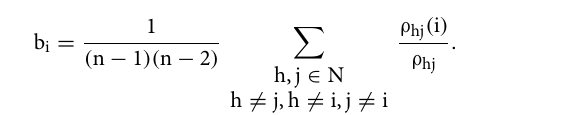
Clustering coefficient. Clustering coefficient assesses a node’s neighbours’ relative connectivity 22 . Specifically, Clustering coefficient evaluates connectivity by determining the number of neighbours which are closed triplets (i.e. a node that is connected to two different nodes that are connected to each other; G-Y-T, for example in Fig. 2B) versus all triplets. The more connected a node’s neighbours are the higher a node’s clustering coefficient is. For example, node G has five neighbours. Two out of those five neighbours have a closed triplet, so G has a lower clustering coefficient compared to node V in which all neighbours contain closed triplets. Clustering coef- ficient can be defined below, where C w is the weighted clustering coefficient, t iw denotes the number of triplets around i, and k being the number of edges that are connected to the vertex i 23 :